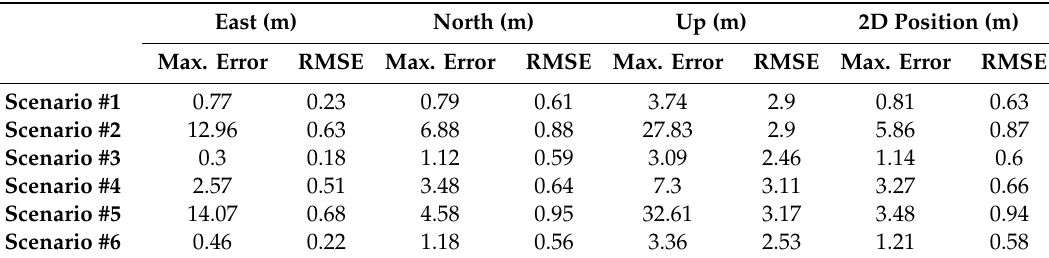
Table 9. Positioning error for all scenarios.